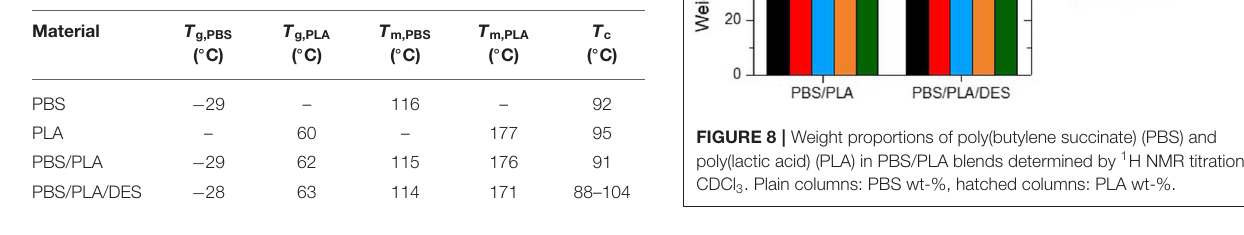
CDCl 3 . Plain columns: PBS wt-%, hatched columns: PLA wt-%.